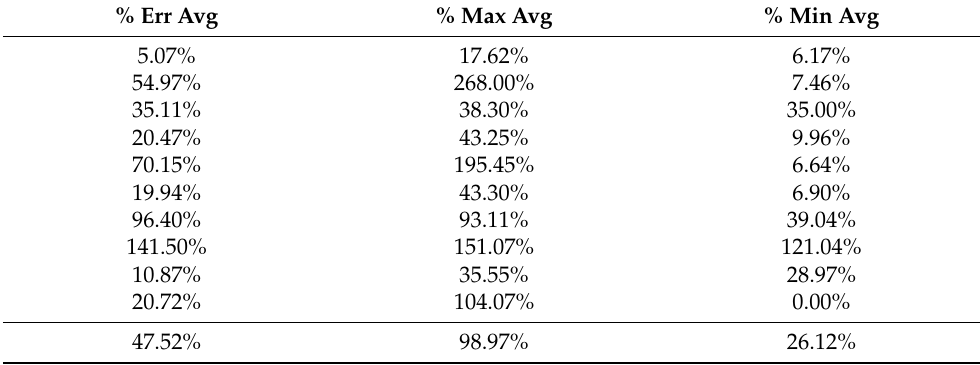
Table A195. Set 3, trials 21–30 data (actual PR value).